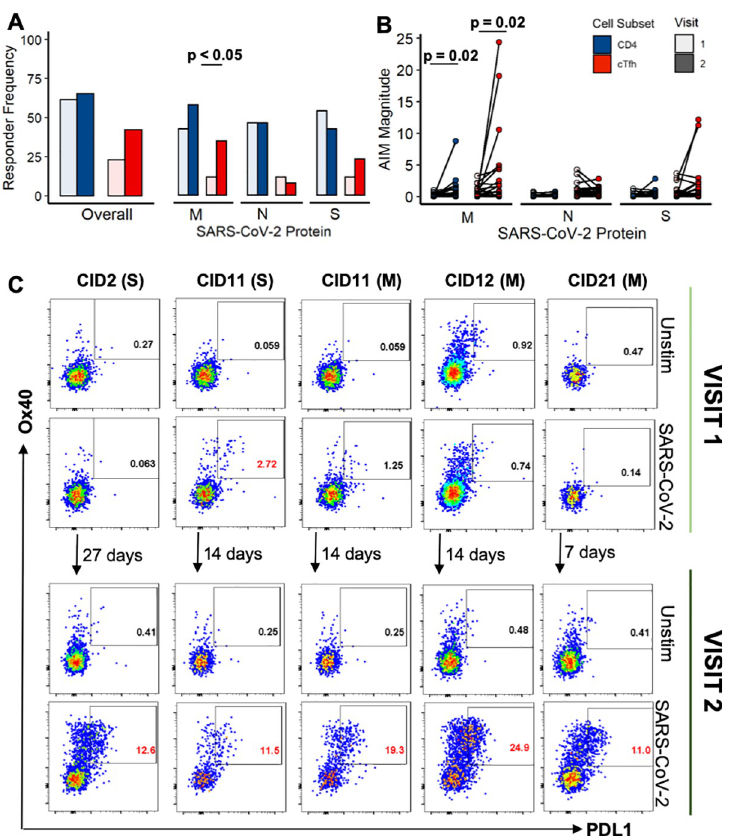
Fig 4. M protein-specific cTfh responses increase from the first to the second convalescent visit (N = 26). (A) Paired convalescence Visit 1 and Visit 2 CD4 T-cell and cTfh response magnitudes by AIM (p values determined by Fisher’s Exact Test). (B) Paired CD4 T-cell and cTfh response magnitudes for AIM (p values determined by a paired Wilcoxon Signed-Rank Test). (C) Flow plots for both the first (top) and second (bottom) convalescent visit of individuals where robust cTfh responses ( > 5%) developed. Unstimulated negative control shown for each. SARS-CoV-2 protein to which response is directed is listed next to the PTID in parentheses. Positive SARS-CoV- 2-specific responses are indicated by gate frequencies in